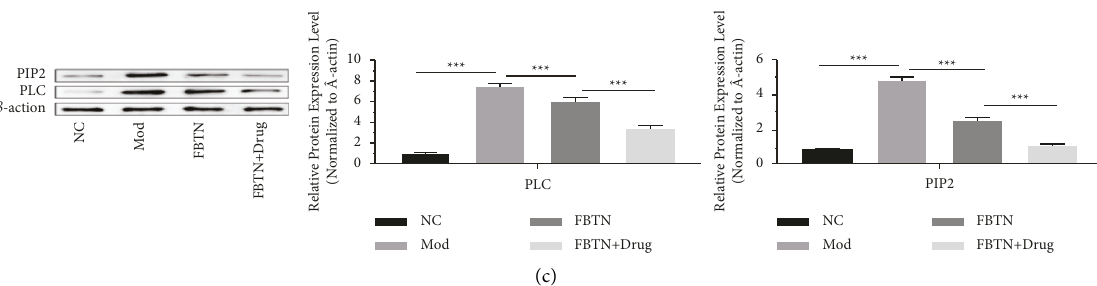
Figure 4: Abdominal massage attenuated IBS-induced activation of the trypase-PAR2-PKC ε pathway. (a) Representative images of trypase IHC staining (left panel) and trypase AOD value analyzed with ImageJ software (right panel). (b) Detection of PAR2 and PKC protein levels in small intestinal mucosa tissues from the normal, IBS, abdominal massage, and ketotifen treatment groups by western blot (left panel: representative images of PAR2 and PKC western blot; middle panel, a summary of relative PKC levels in four groups; right panel, a summary of relative protein levels of PAR2 in four groups. Data were normalized to GAPDH). (c) Detection of PLC and PIP2 protein levels in small intestinal mucosa tissues from the normal, IBS, abdominal massage, and ketotifen treatment groups by western blot (right panel: rep- resentative blots of PLC and PIP2; middle panel, a summary of relative PLC levels in four groups; right panel, a summary of relative protein levels of PIP2 in four groups. Data were normalized to GAPDH). ∗ P < 0 . 05, ∗∗ P < 0 . 01, ∗∗∗ P < 0 .